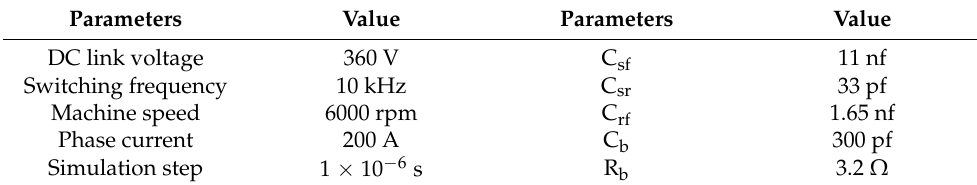
Table 1. Parameters of the simulation